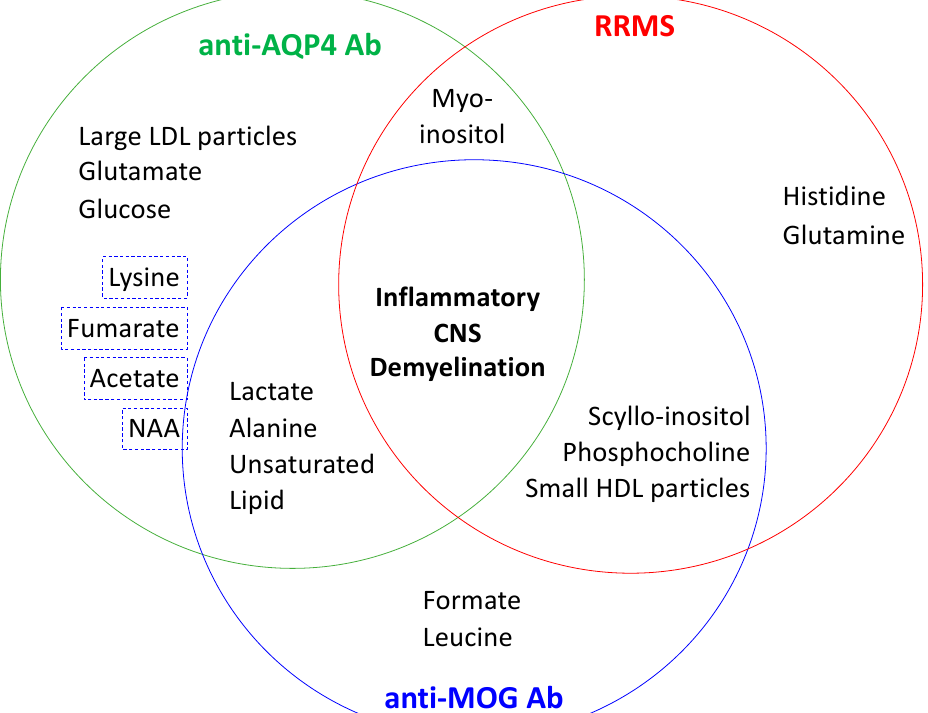
Figure 1. Circulating Metabolites that Discriminate between AQP4-Ab + NMOSD, MOG-Ab + NMOSD, and RRMS. The clinical manifestations of auaporin-4 (AQP4)-antibody (Ab) neuromyelitis optica spectrum disorder (NMOSD), myelin oligodendrocyte glycoprotein (MOG)-Ab NMOSD, and relapsing remitting multiple sclerosis (RRMS) overlap. Given that (1) the clinical